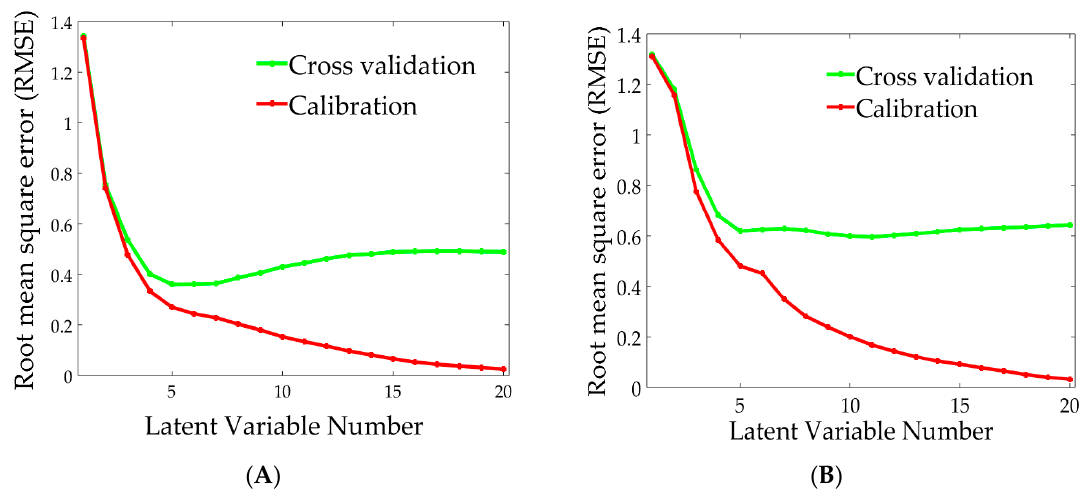
Figure 4. Root mean square error (RMSE) of calibration and cross validation regression analyses in the prediction of potato storage period at 5 ◦ C according to the latent variables that are included in the model based on the wavelength regions that were previously identified with the genetic algorithm as a feature extraction technique of the spectra that were captured externally on the skin ( A ) and internally in the flesh ( B ) of the tubers.